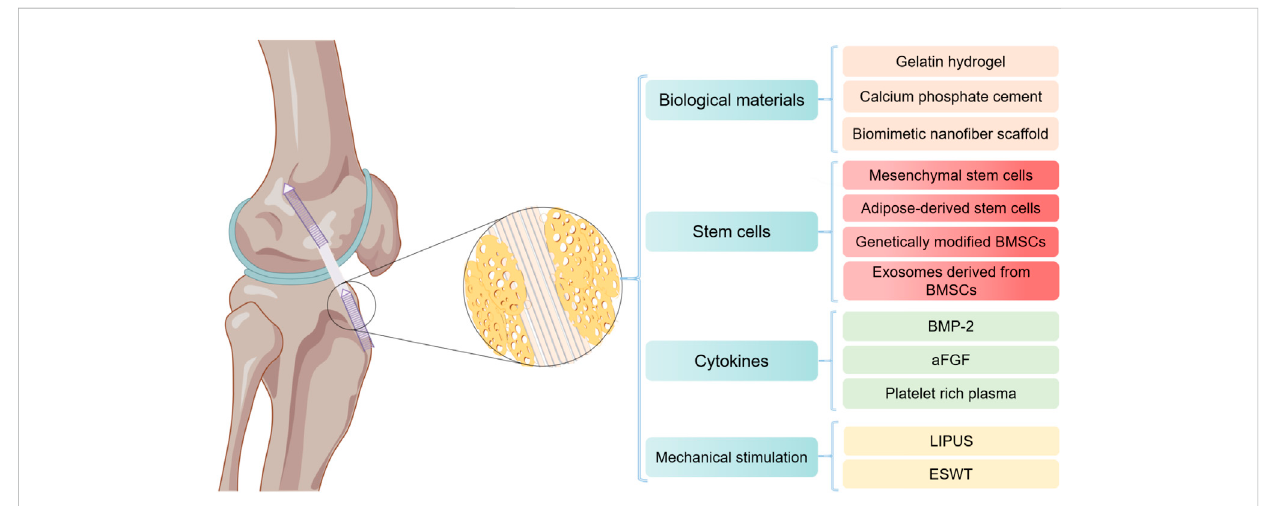
FIGURE 3 Major strategies for promoting tendon-bone healing after ACL reconstruction by Figdraw. BMSCs, bone mesenchymal stem cells; BMP-2, bone morphogenetic protein-2; aFGF, acidic fi broblast growth factor; LIPUS, low intensity pulsed ultrasound; ESW, extracorporeal shock wave.